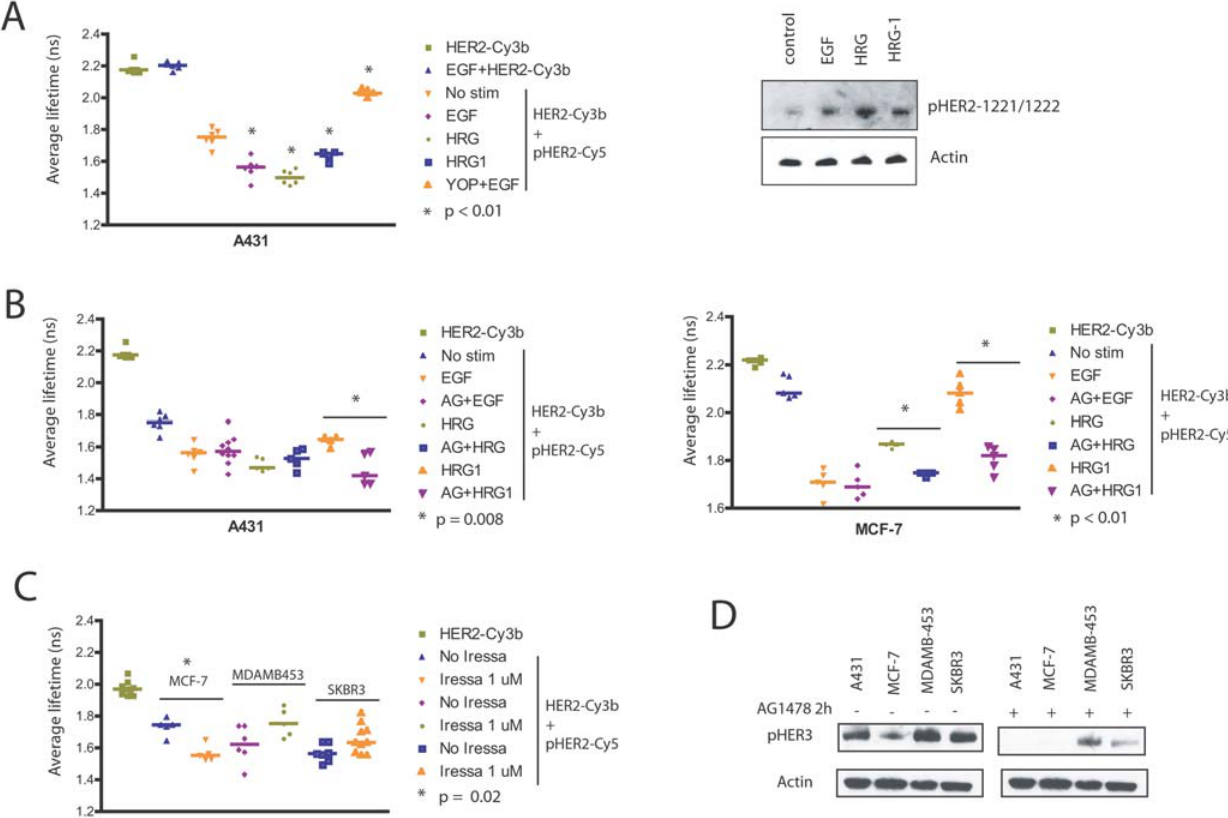
Figure 1. Inhibition of EGFR with AG 1478 and Iressa does not abolish HER2 phosphorylation. A, Displayed is the average lifetime of HER2-Cy3b in A431 cells treated under different conditions as indicated. Each point represents one measurement of the average lifetime of HER2- Cy3b in A431 cells (single cell or group of cells in a single field) with the lines representing the median average lifetime of all the cells under each condition. To assess HER2 activation in A431 cells by FRET, we incubated the cells with either donor alone (HER2-Cy3b) or donor and acceptor (HER2- Cy3b + pHER2-Cy5) after 10 minutes stimulation with either 100 ng/ml EGF, 100 ng/ml heregulin b (HRG) or 100 ng/ml heregulin b -1 (HRG1). To remove phosphotyrosine, the phosphatase YOP was used following stimulation of the cells with EGF. On the right panels, near confluent A431 cells were stimulated with EGF, heregulin b and heregulin b -1 for 10 minutes. 10 m g of protein was used for western blot analysis. The phosphorylation of HER2 on Tyr1221/1222 was determined with a phosphospecific antibody. B, A431 cells (left graph) were pre-treated with 3 m M of the tyrosine kinase inhibitor AG 1478 (AG) for two hours before stimulation with either EGF, heregulin b or heregulin b -1 as indicated. The average lifetime of HER2-Cy3b for those cells pre-treated with AG 1478 was compared with those without treatment using the Mann-Whitney test. The same experiment was also performed in MCF-7 cells (right graph). C, MCF-7, MDAMB-453 and SKBR3 cells were pre-treated with 1 m M Iressa for 2.5 days before assessing their HER2 phosphorylation as above. D, A431 cells, MCF-7, MDMAB-453 and SKBR3 were pre-treated with 1 m M AG 1478 for two hours. The cells were treated with lysis buffer and proteins separated by SDS-PAGE. The phosphorylation of HER3 on Tyr1289 was determined using an anti- phosphospecific antibody. various breast cells. Figure 1C shows that acute treatment with 1 m M Iressa did not abolish basal HER2 phosphorylation in MCF-7 cells but induced a significant increase in its phosphor- ylation, resulting in a further decrease of lifetime (p= 0.02